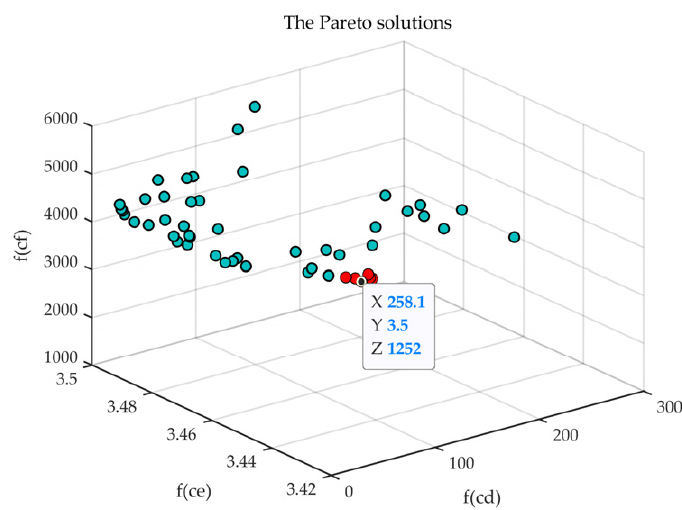
Table 3. Parameters of MOPSO. Parameters